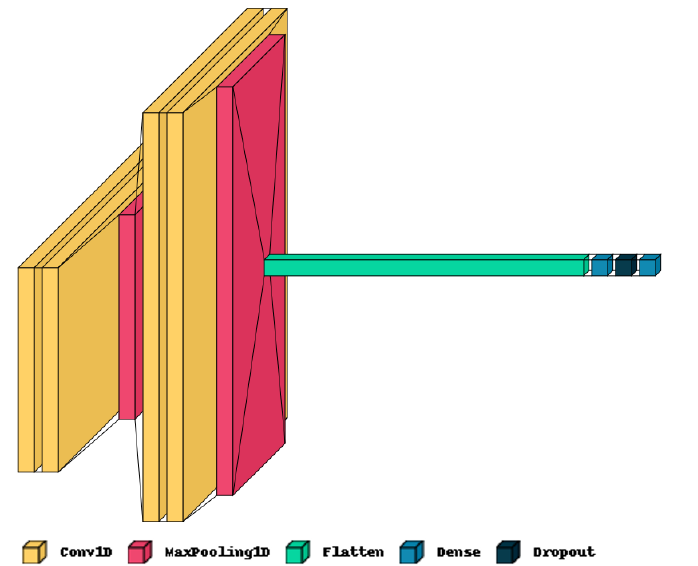
Figure 2. Structure of proposed convolutional neural